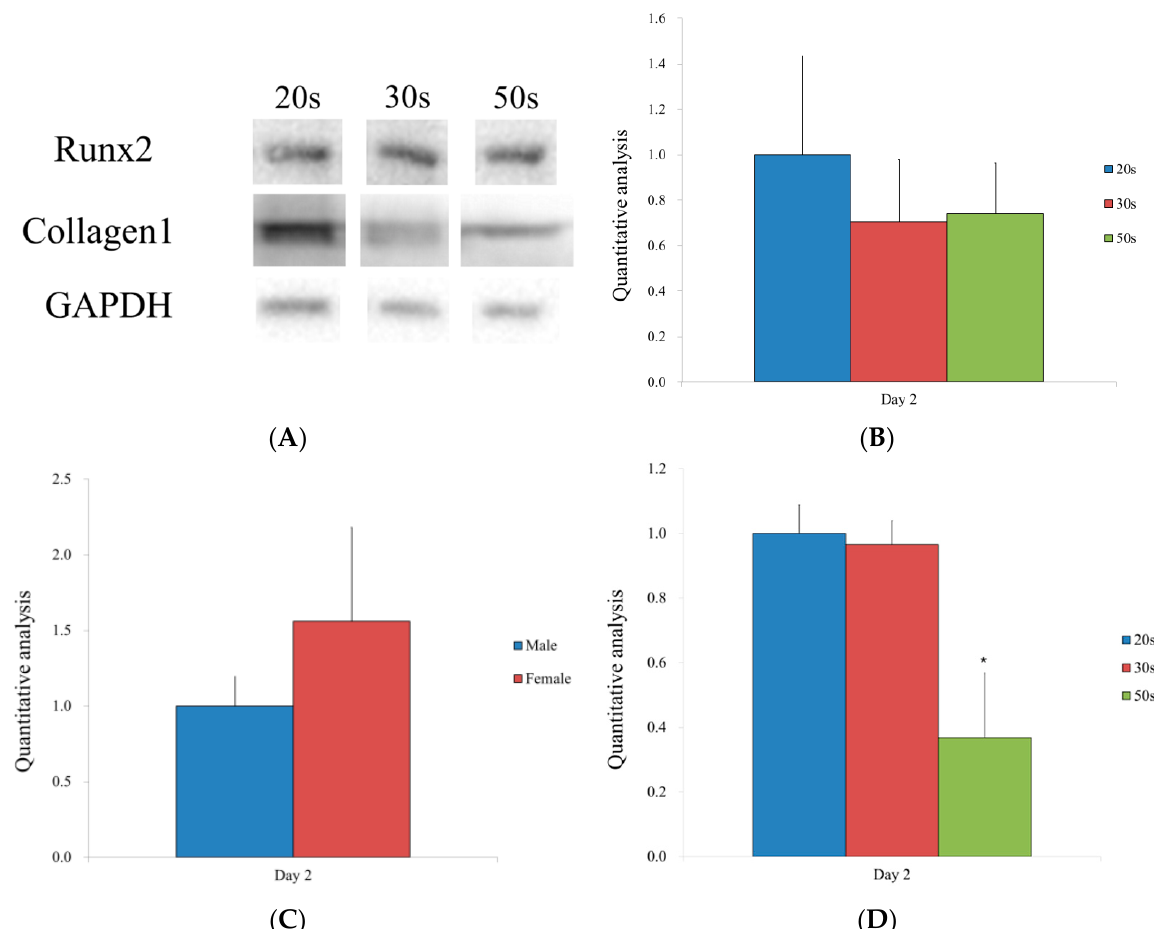
Figure 4. ( A ) Western blot analysis to detect the protein expressions of Runx2, collagen I, and GAPDH by hBMSCs. The experimental lanes were run in tandem. ( B ) Quantitative analysis of Runx2 levels by age. ( C ) Quantitative analysis of the Runx2 expression by sex. ( D ) Quantitative analysis of the collagen I expression by age. * Significant differences were noted when compared with the results of the 20s group.